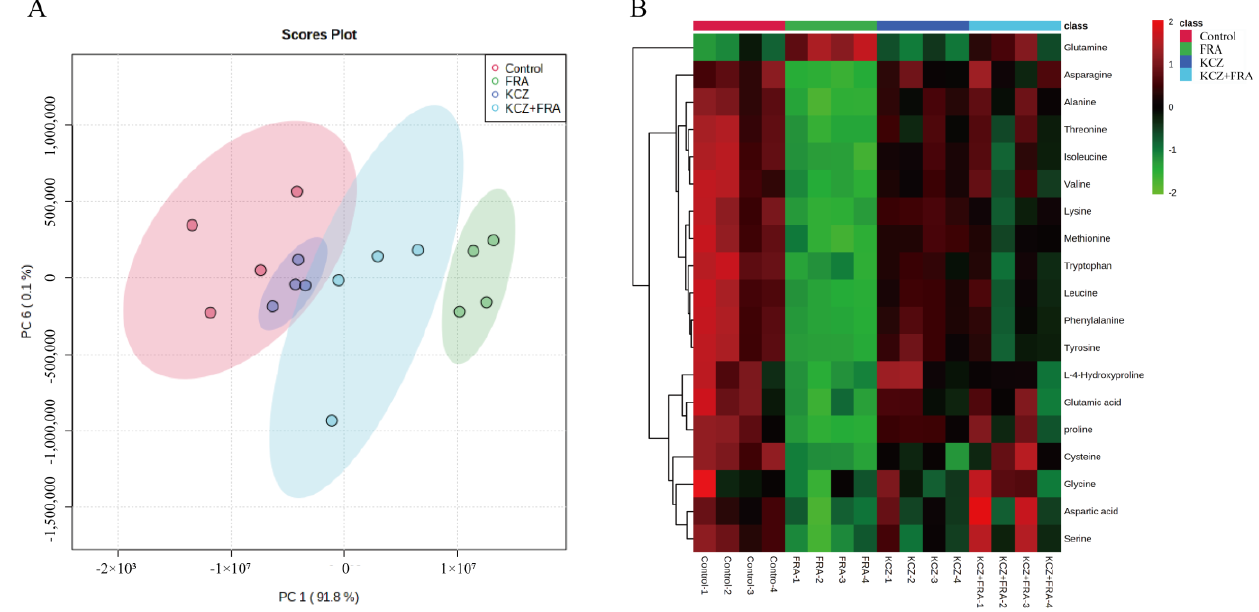
Figure 8. KCZ restored the amino acid metabolism spectrum altered by FRA. ( A ) PCA scores of zebrafish larvae samples in the control, FRA, KCZ, and KCZ and FRA groups. The 95% confidence intervals are shown. ( B ) A heatmap showing changes in the contents of 19 amino acids related to zebrafish liver injury obtained by GC-MS/MS. Each experiment was performed 3 times with 40 randomly selected zebrafish larvae.